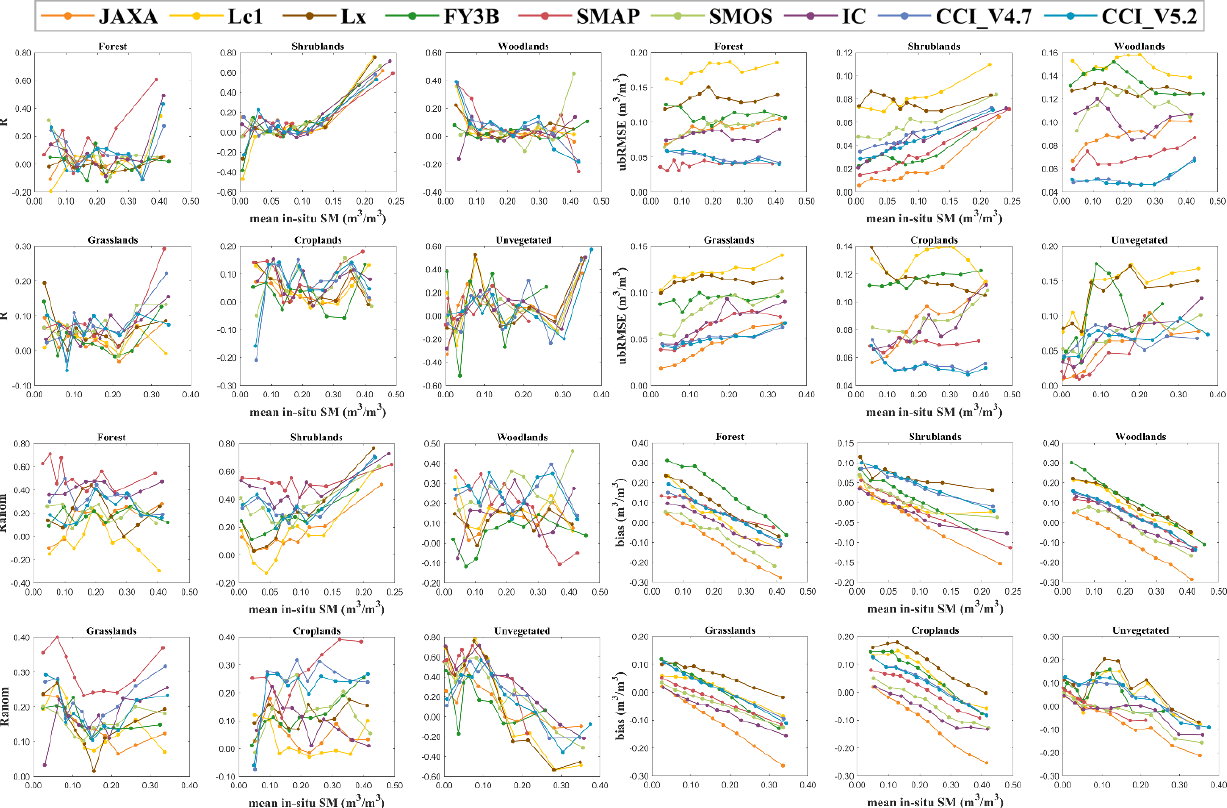
Figure 11. Same as Figure 10 but with varying SM.